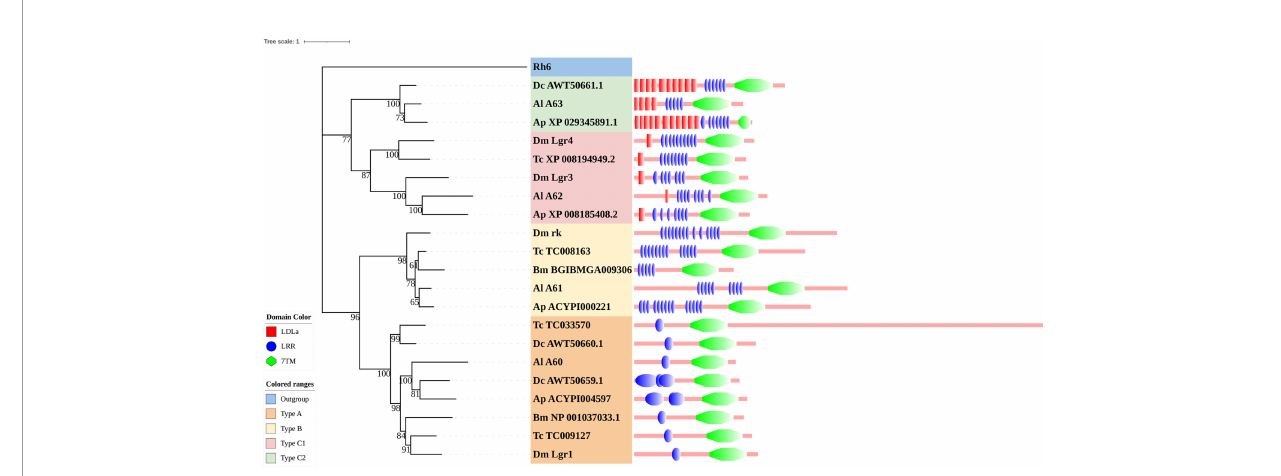
FIGURE 6 | Phylogenetic tree and domains of different LGRs. Numbers at nodes on the tree were the bootstrap values (below 50 are not shown). The tree was rooted by the D. melanogaster opsin GPCR Rh6. Different LGR types were painted with different colors. Predicted domains of each sequence are shown in the corresponding branch side. Dc, D . citri ; Al, A. lucorum ; Ap, A . pisum ; Dm, D . melanogaster ; Tc, Tribolium castaneum ; Bm, B . mori .